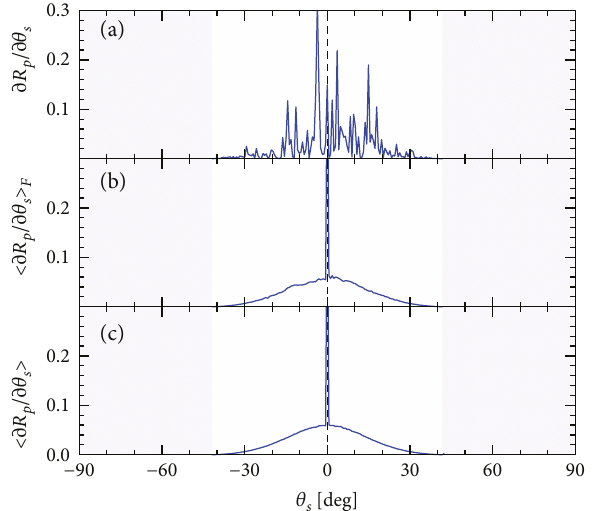
Figure 6: Same as Figure 5 ( ε polarized